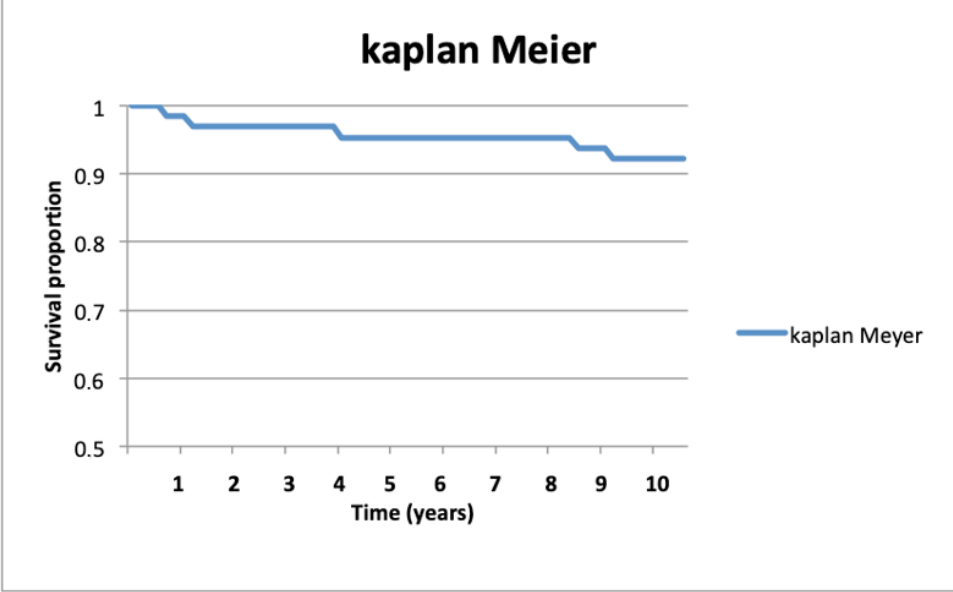
Figure 1. Kaplan–Meier curve at 10 years.